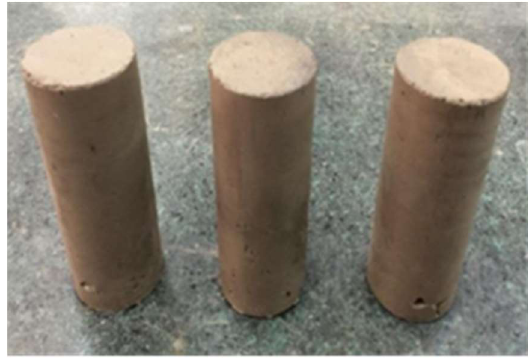
Figure 2. Sample diagram of fiber cement soil.